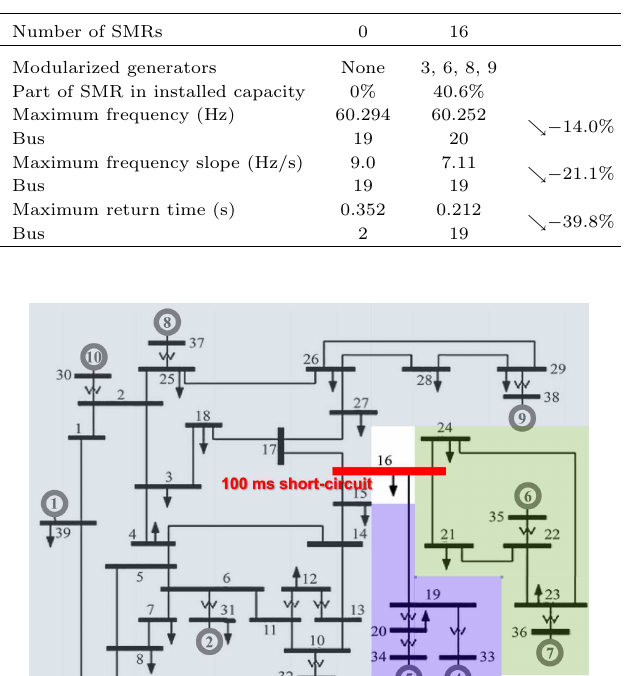
Fig. 16. Evolution of maximum return time against the part of modularized installed capacity in the grid. Table 1. Estimator results for the extreme cases of modularization.